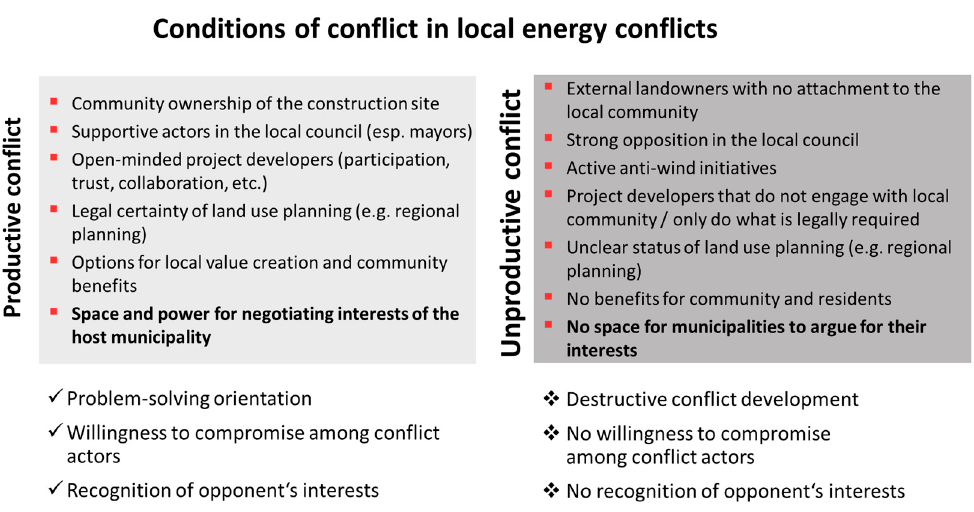
Figure 1. Local conflict conditions in the development of renewable energy infrastructures. Source: Own representation.